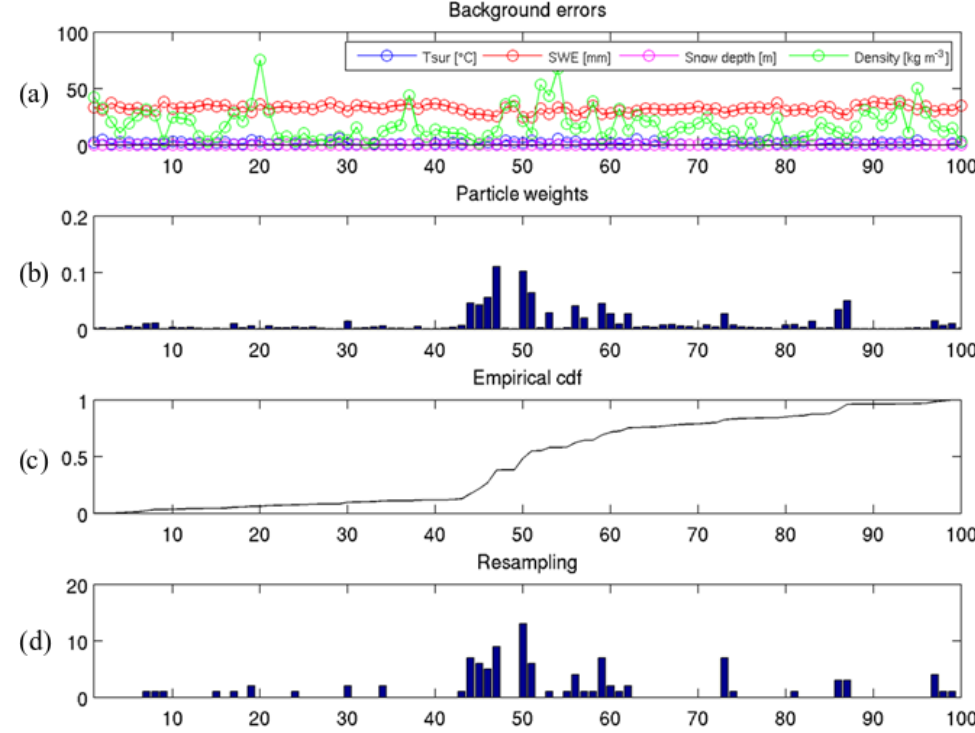
Figure 2. SIR-PF scheme for multivariate DA: (a) open circles are the background errors for surface temperature (in blue), SWE (in red), snow depth (in magenta) and snow density (in green). (b) Importance weights as a function of the particle indices. (c) Empirical cdf of the weights. (d) Number of resampled particles as a function of the particle